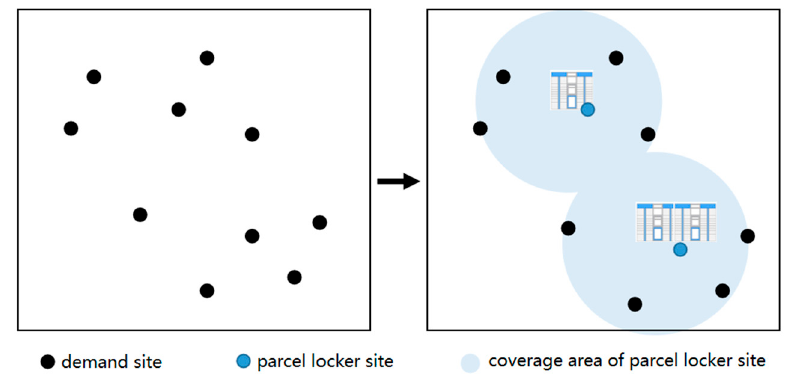
Figure 1. Location selection problem of parcel lockers.